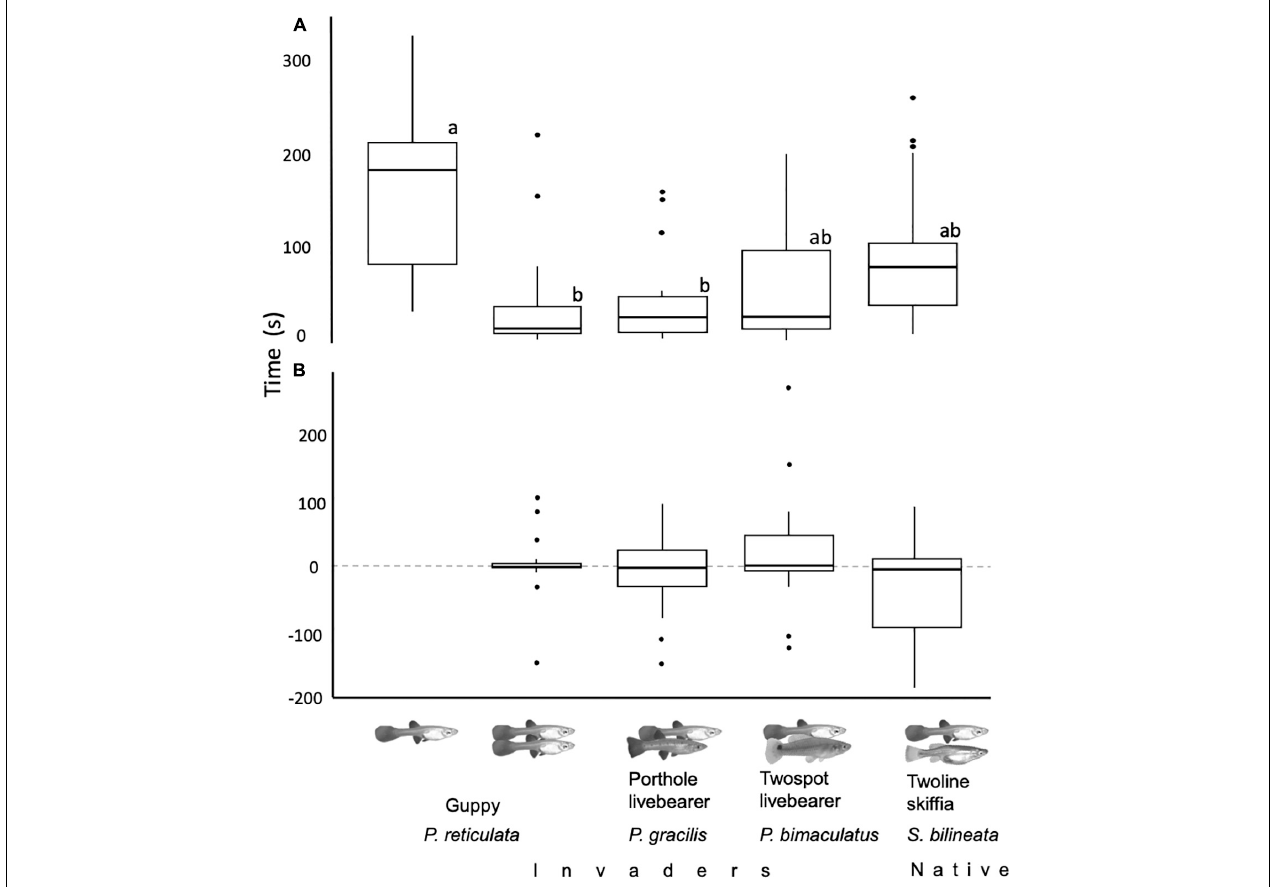
FIGURE 2 | (A) Time it took focal guppies to exit the refuge between treatments was different. They took longer to exit the refuge when alone than when accompanied, lower case letters represent significant differences between treatments. (B) Differences between the emergence latency of the first and the second fish were similar between treatments; positive numbers mean focal exited first and negative companions exited first. For both panels centerlines of boxplots represent the median, top and bottom of boxes represent the 25th and 75th percentile, while dots outliers.